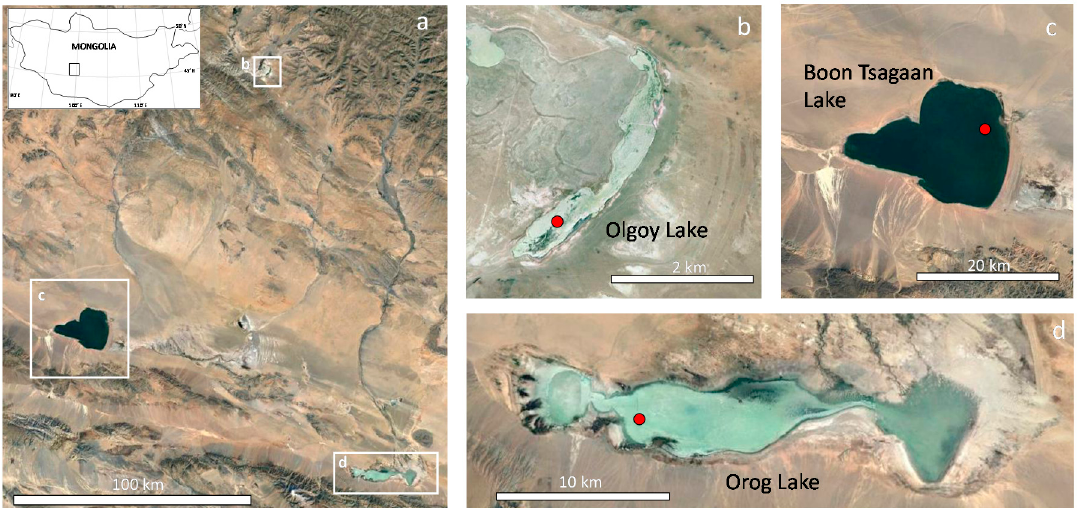
Figure 1. Google Earth images of ( a ) the Valley of Gobi Lakes (location in Mongolia provided in the inset map), ( b ) Olgoy Lake, ( c ) Boon Tsagaan Lake, and ( d ) Orog Lake. Red circles in ( b – d ) indicate the sampling points in each lake.